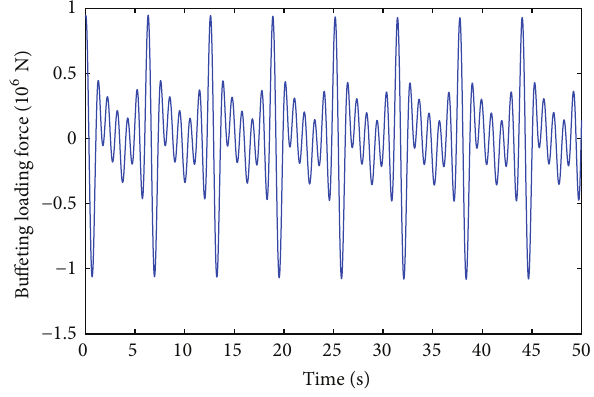
Figure 3: Buffeting loading force curve.